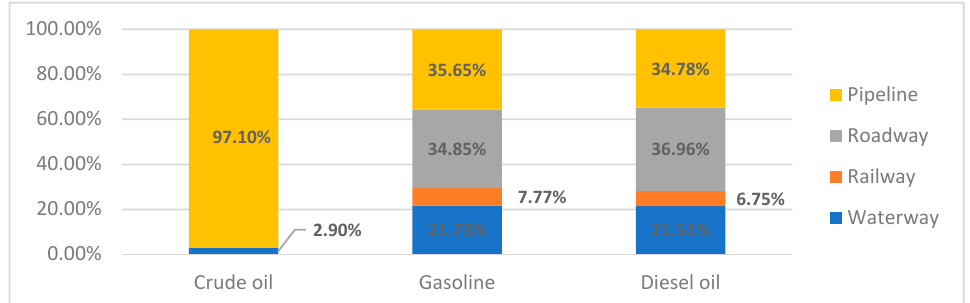
Figure 7. Transportation mode sharing.